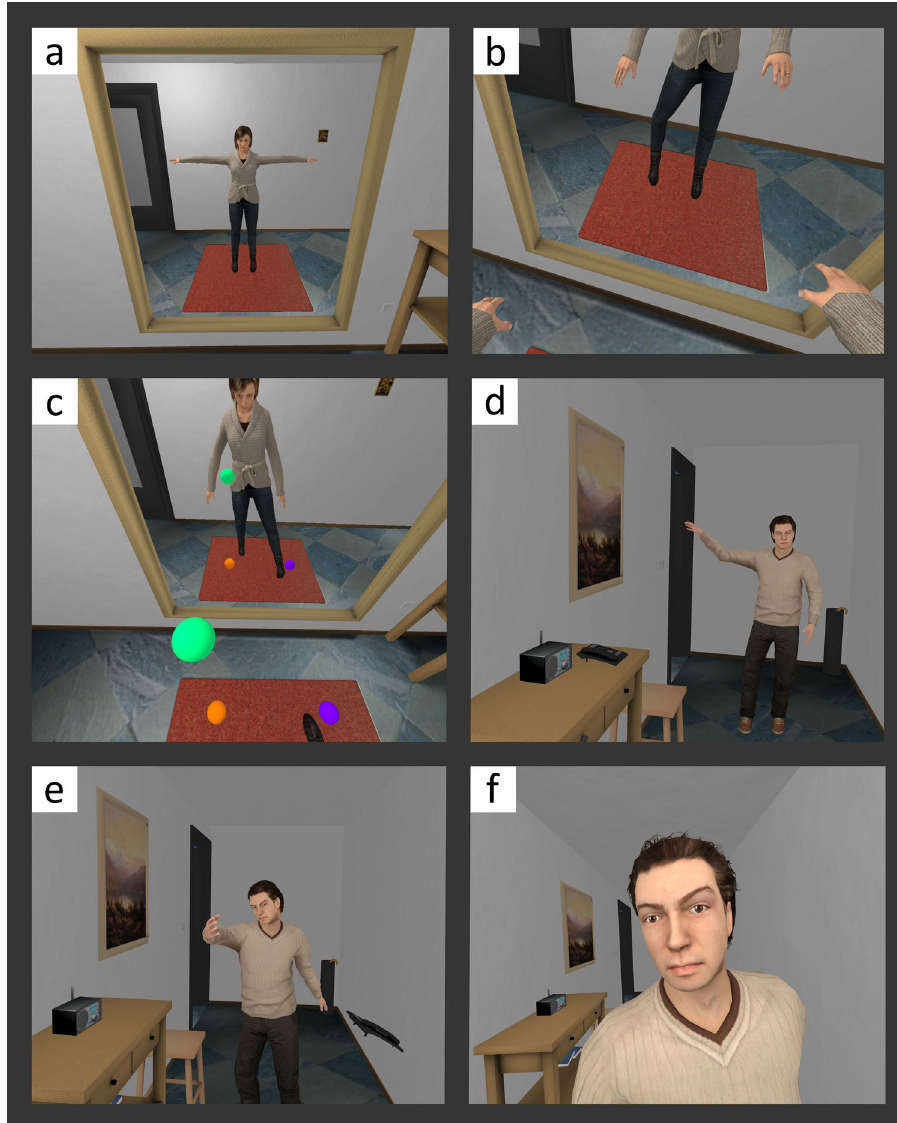
Figure 1. The immersive virtual reality scenario. ( a ) The participant looks at his female virtual body in the mirror. ( b ) The participant looks down towards his own body from a first-person perspective. ( c ) The participant touches the virtual balls. ( d ) The male virtual character enters the room and starts to verbally abuse the female virtual character. ( e ) The male virtual character throws a telephone on the floor. ( f ) The male virtual character invades the personal space of the